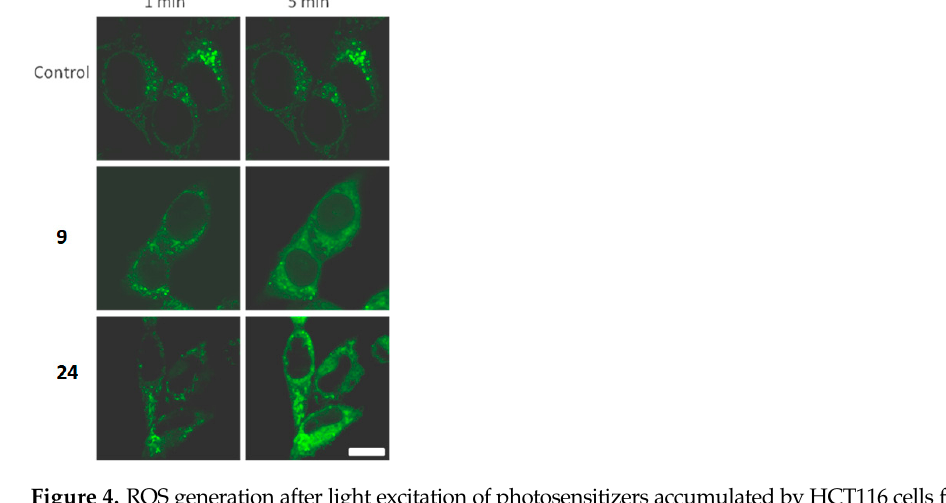
and 24 (10 μ M each) for 24 h at 37 °C, 5%CO 2 in the dark. Colocalization with mitochondria ( A ),